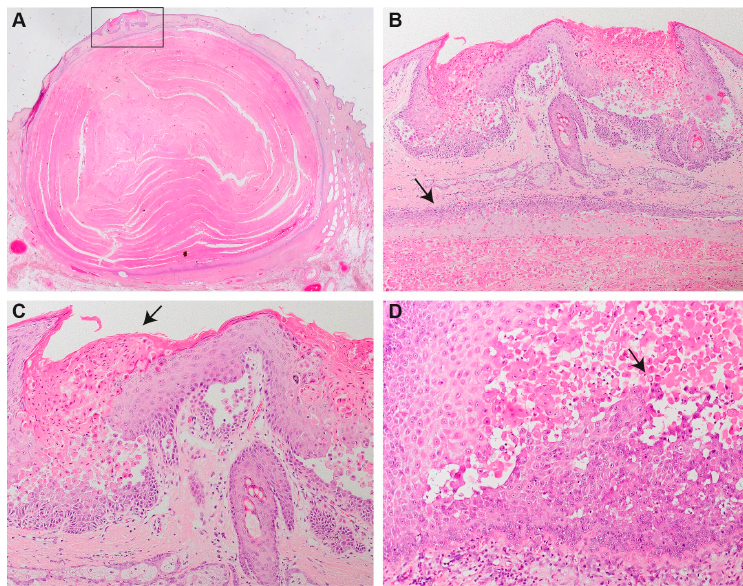
Figure 2. Histopathology. ( A ) Infundibular cyst underneath a focal area of hyperplastic epidermis with abundant suprabasal acantholyisis (rectangle). ( B ) Higher magnification of the focal area of hyperplastic epidermis with suprabasal acantholysis overlying the cyst wall (arrow). The epidermal plaque is characterized by severely irregularly hyperplastic epidermis with abundant suprabasal acantholytic and dyskeratotic keratinocytes forming the “corps ronds” typical for Darier disease. Keratotic plugs composed of parakeratotic keratin and grains extend into the clefts resulting from abundant acantholysis. The hyperplastic plaque is overlying an infundibular cyst composed of squamous epithelium with abundant suprabasal acantholysis. The cyst is filled with parakeratotic keratin and numerous “corps ronds”. ( C ) Higher magnification of the lesions already presented in ( A ),( B ). Note the abundant suprabasal acantholyis of dyskeratotic keratinocytes forming “corps ronds”, “grains” and parakeratotic keratin (arrow). ( D ) Hyperplastic plaque from the outer ear canal. Within the severely hyperplastic epidermis, numerous acantholytic and dyskeratotic keratinocytes forming “corps ronds” (arrow) and causing small clefts are present. In all biopsies from haired skin, one or multiple infundibular cysts measuring between 0.8 × 0.5 × 0.5 cm up to 3.5 × 3.0 × 1.2 cm were extending from the upper dermis to the subcutis. The cysts were lined by squamous epithelium, which presented with abundant acantholysis of suprabasal keratinocytes. The cysts were filled with parakeratotic keratin and numerous acantholytic and dyskeratotic cells. In one biopsy from the neck, the epidermis overlying the cyst presented with severe hyperplasia and suprabasal acantholysis comparable to the findings described for the outer ear canal. Similar findings were also present in the infundibular epithelium of some hair follicles. 3.3. Identification of a Candidate Causative Variant We sequenced the genome of the affected dog at 32 × coverage and called single nucleotide and small indel variants with respect to the reference genome. The variants were compared to whole genome sequence data of 8 wolves and 647 control dogs from genetically diverse breeds and searched for private protein-changing variants in the two functional candidate genes ATP2A2 and ATP2C1 .